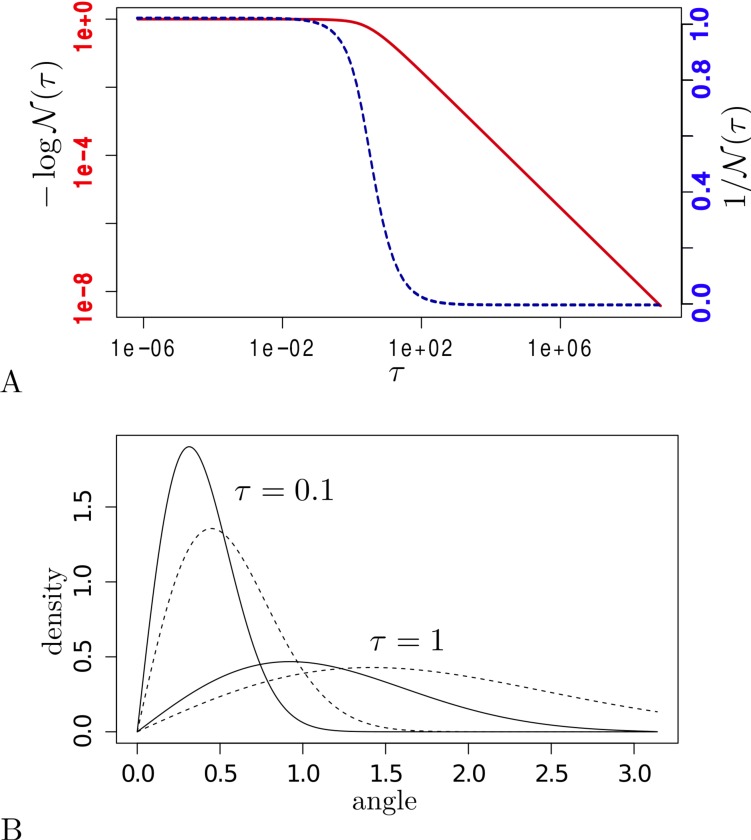
(A) \documentclass[12pt]{minimal}
\usepackage{amsmath}
\usepackage{wasysym}
\usepackage{amsfonts}
\usepackage{amssymb}
\usepackage{amsbsy}
\usepackage{upgreek}
\usepackage{mathrsfs}
\setlength{\oddsidemargin}{-69pt}
\begin{document}
}{}$1{}\mathcal{N}(\mathrm{&tau;})$\end{document}1∕Nτ (y-axis) for different values of τ = b∕t (x-axis) on a log–log scale (left axis, solid line) and normal-log scale (right axis, dashed line). (B) density functions (y-axis) for spherical diffusion (solid lines) and planar diffusion (dashed lines) with τ = 0.1 and τ = 1.0. The x-axis is the angle for spherical diffusion and distance to start point for planar diffusion.